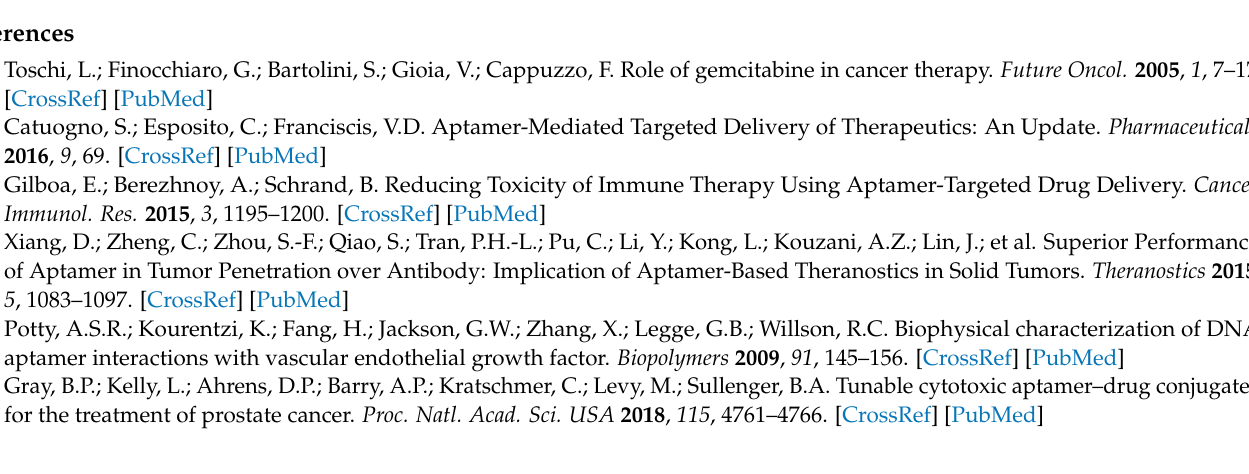
Figure S11: Maldi mass spectrum of compound 14 in Scheme S1; Figure S12: ESI mass spectrum of compound 14 in Scheme S1; Figure S13: HPLC chromatogram. purification of Apt-cL-triGemcitabine conjugate products by semi-preparative reversed-phase HPLC; Figure S14: ESI mass spectrum of byproduct. Figure S15: HPLC chromatogram of TNM-linker-Gemcitabine in different pH buffer; Figure S16: The chromatogram of TNM-linker-Gemcitabine structure post-treatment with inactive cathepsin B enzyme in pH = 5 buffer at 37 ◦ C for 1 h; Figure S17: The chromatogram of TNM-liker- Gemcitabine structure treated with activated cathepsin B enzyme in pH = 5 buffer for 1 h at 37 ◦ C. Table S1: Cell apoptosis and death rates two-days post treatments as